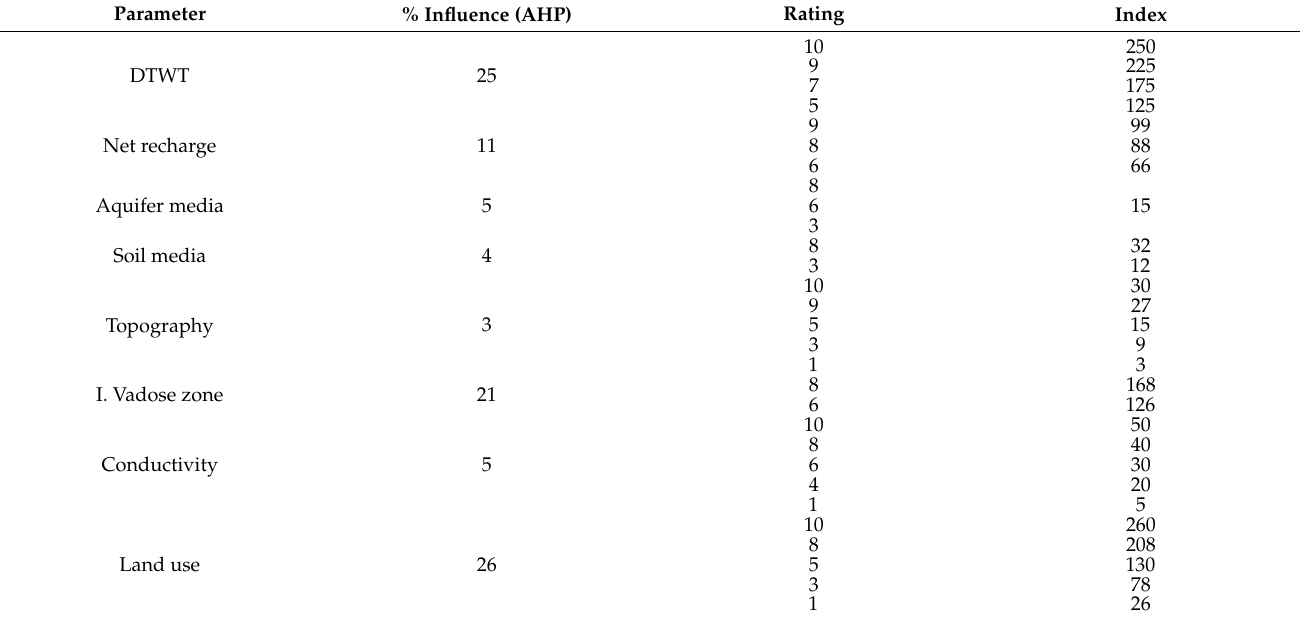
Table 3. The percentage influence of the DRASTIC-LU/LC